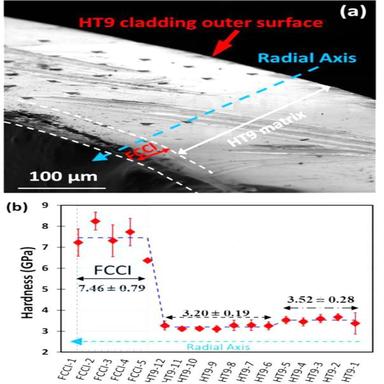
The measured nanoindentation hardness along the radial axis of the HT9 cladding. The average hardness values (with unit GPa) for three zones were inserted for comparison.